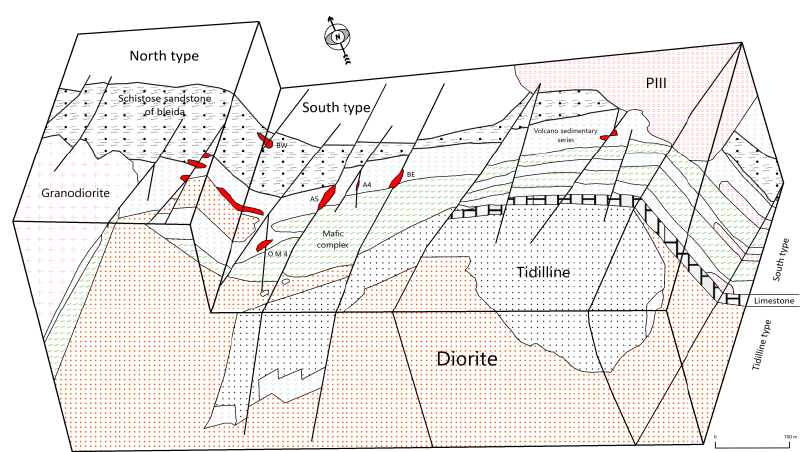
Figure 9. Schematic diagram explaining the structural character of the copper mineralization system at Bleïda modified after [53].